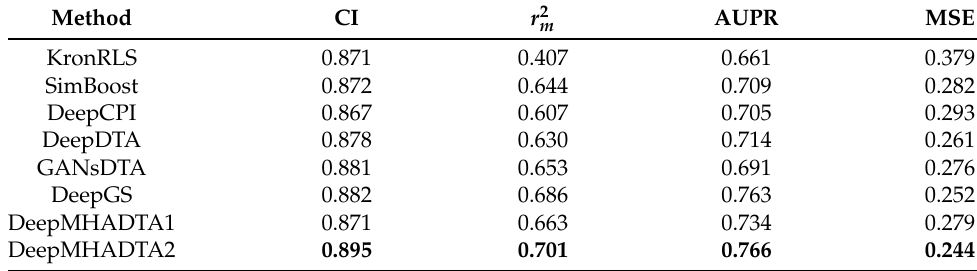
Table 2. Comparison of our method with six competitive methods on Davis dataset.